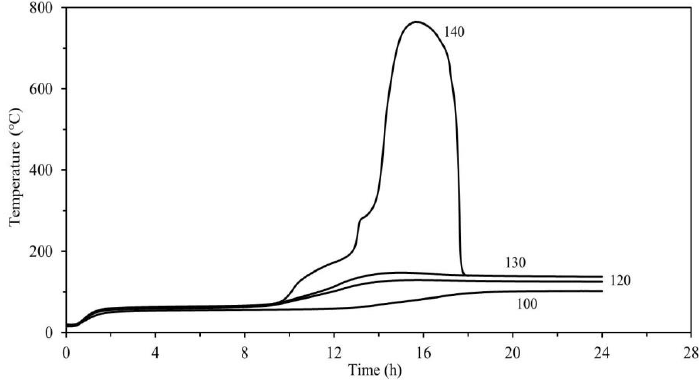
Figure 16. Wire-mesh-cube-testing results for SSSR.